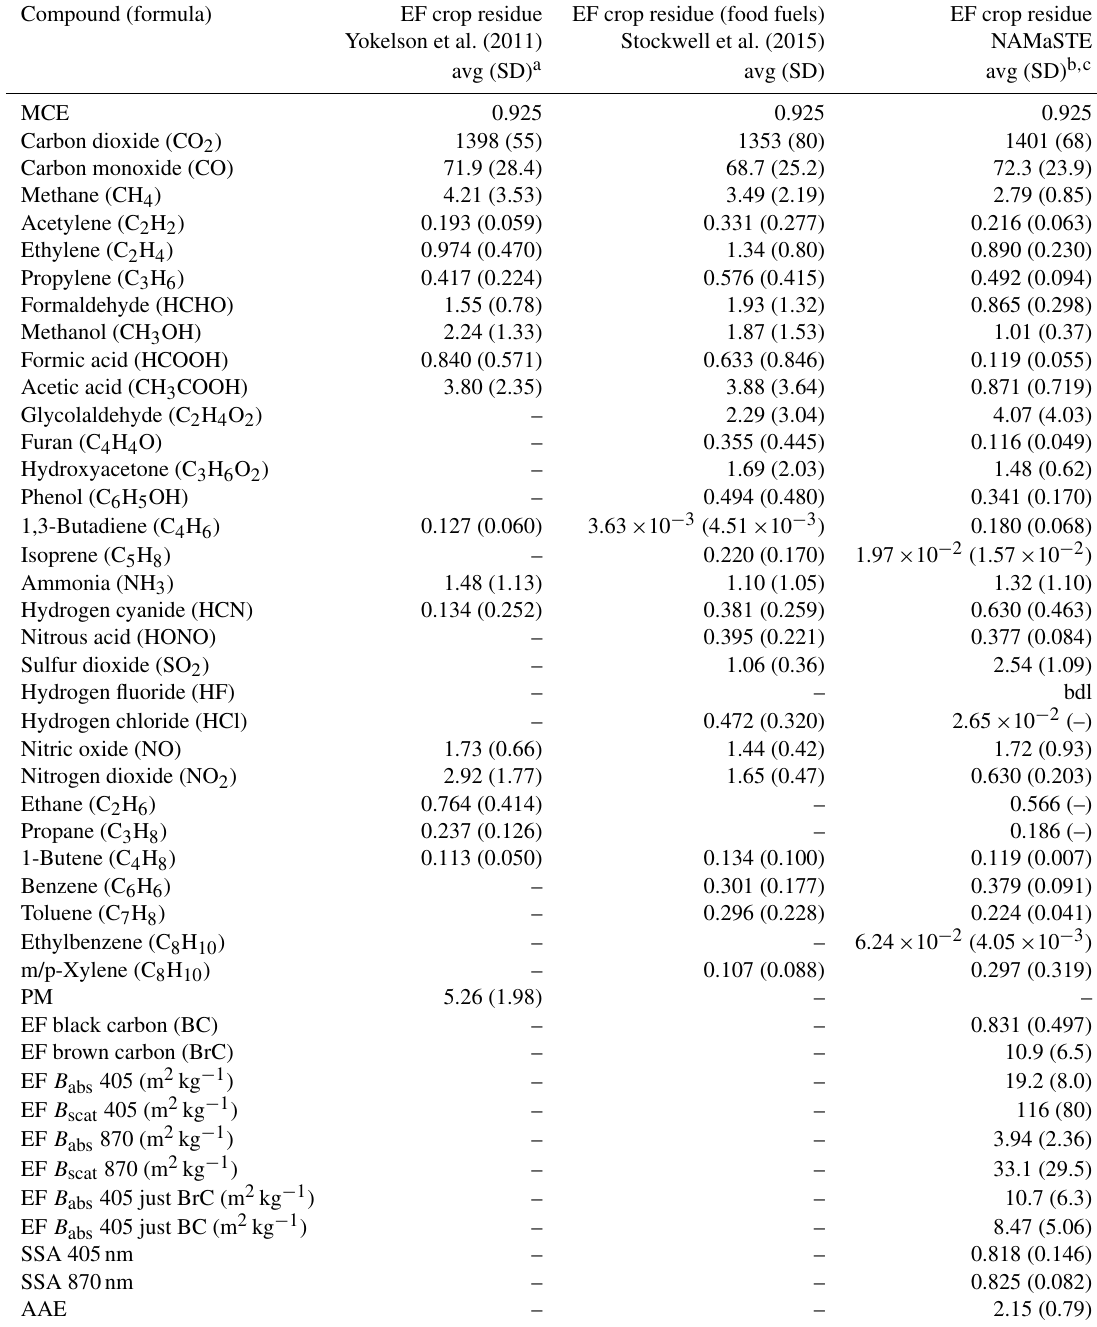
Table 5. Summary of emission factors (gkg − 1 ) and 1 standard deviation for crop residue burns from this study and